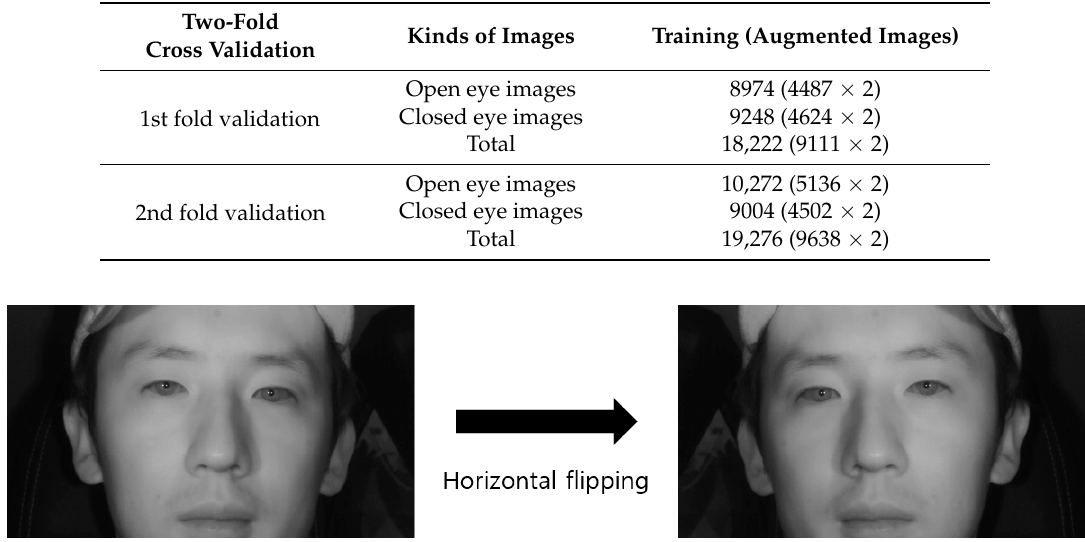
Table 7. Image database for the evaluation of faster R-CNN.